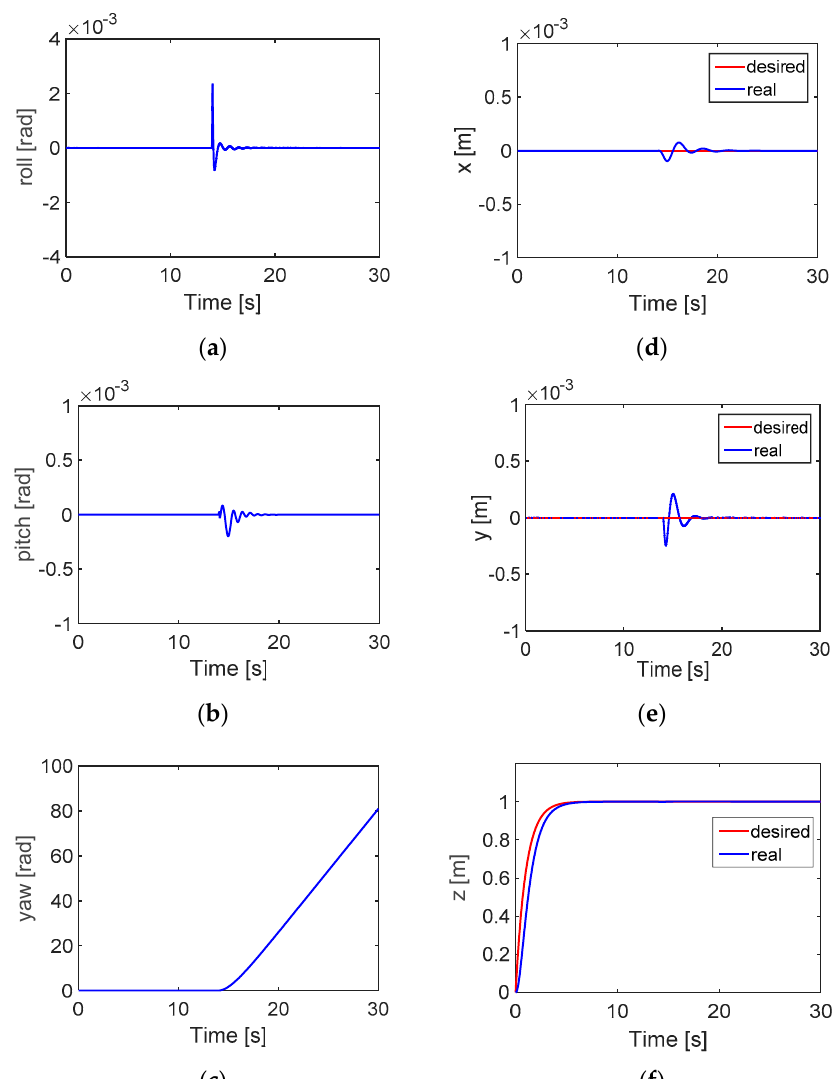
Figure 8. Attitude angles and position response for scenario 1: ( a ) Roll angle, ( b ) Pitch angle, ( c ) Yaw angle, ( d ) x-direction, ( e ) y-direction, and ( f ) z-direction.